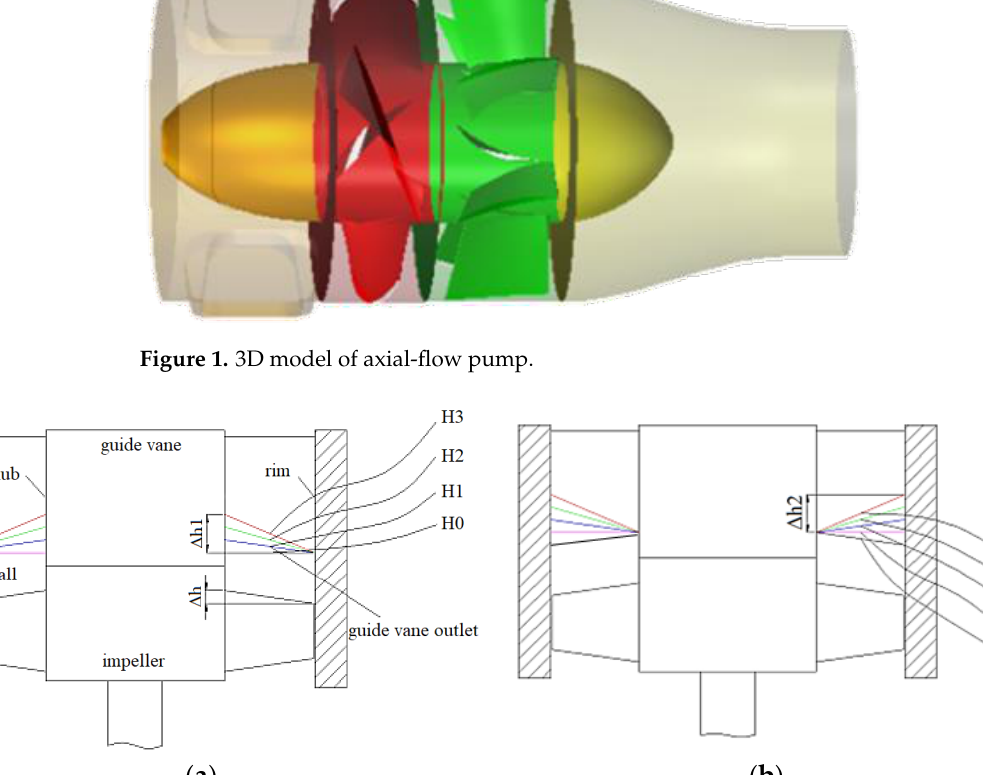
Figure 1. 3D model of axial-flow pump.